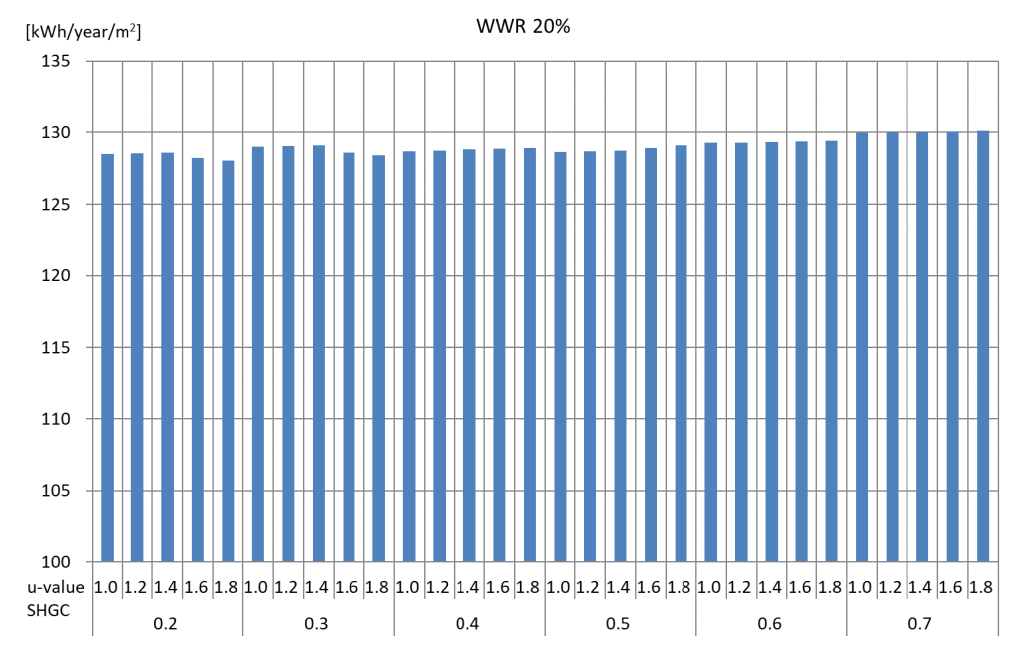
Figure 5. Energy demands/area when WWR = 20%.